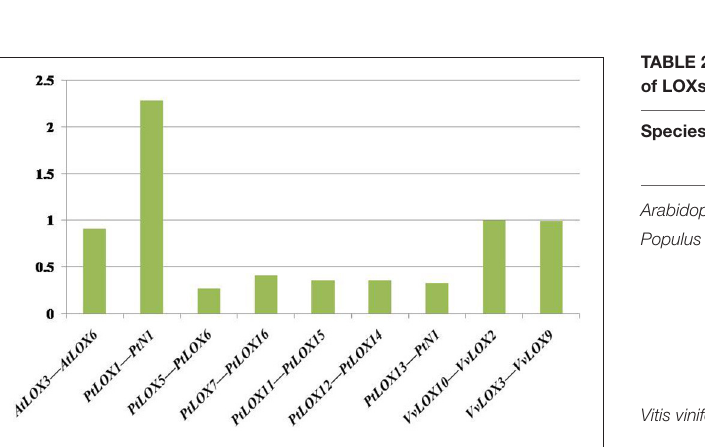
FIGURE 5 | Median Ks values of syntenic chromosomal blocks pairs associated with the expansion of LOX within the genomes of each species. The histogram shows synonymous distances (Ks) between paralogous genes (y-axis) vs. the duplicate gene pairs through segmental or whole-genome duplications (x-axis).